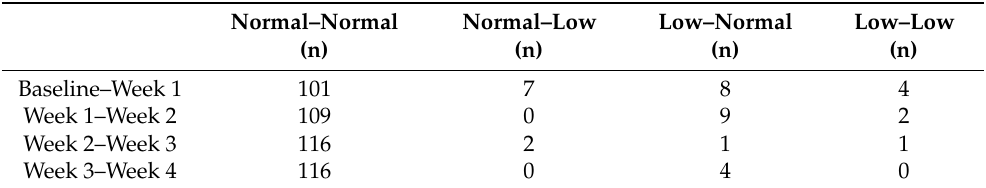
Table 6. Development of phosphate values including a distinction between normal and pathologically low values over 4